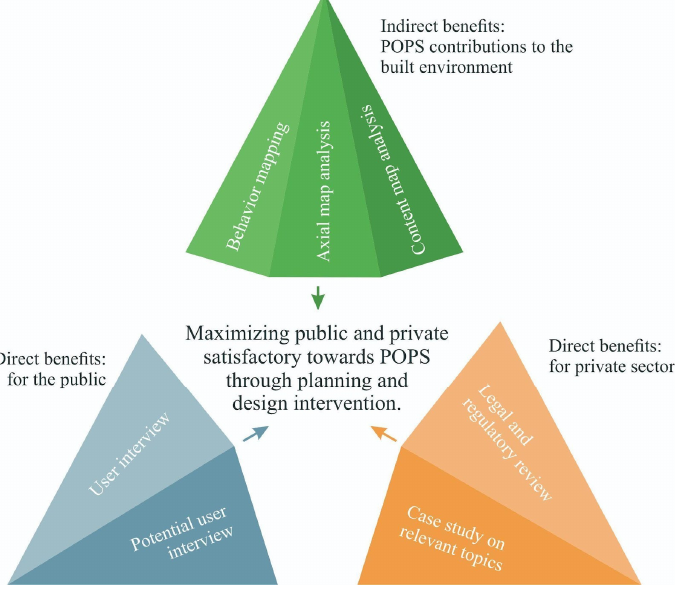
Figure 8. Methods triangulation used in this study to extract data and draw conclusions.